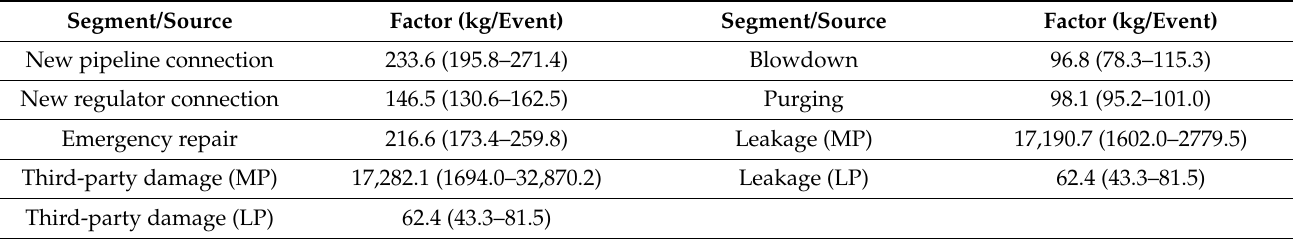
Table 2. Methane emission